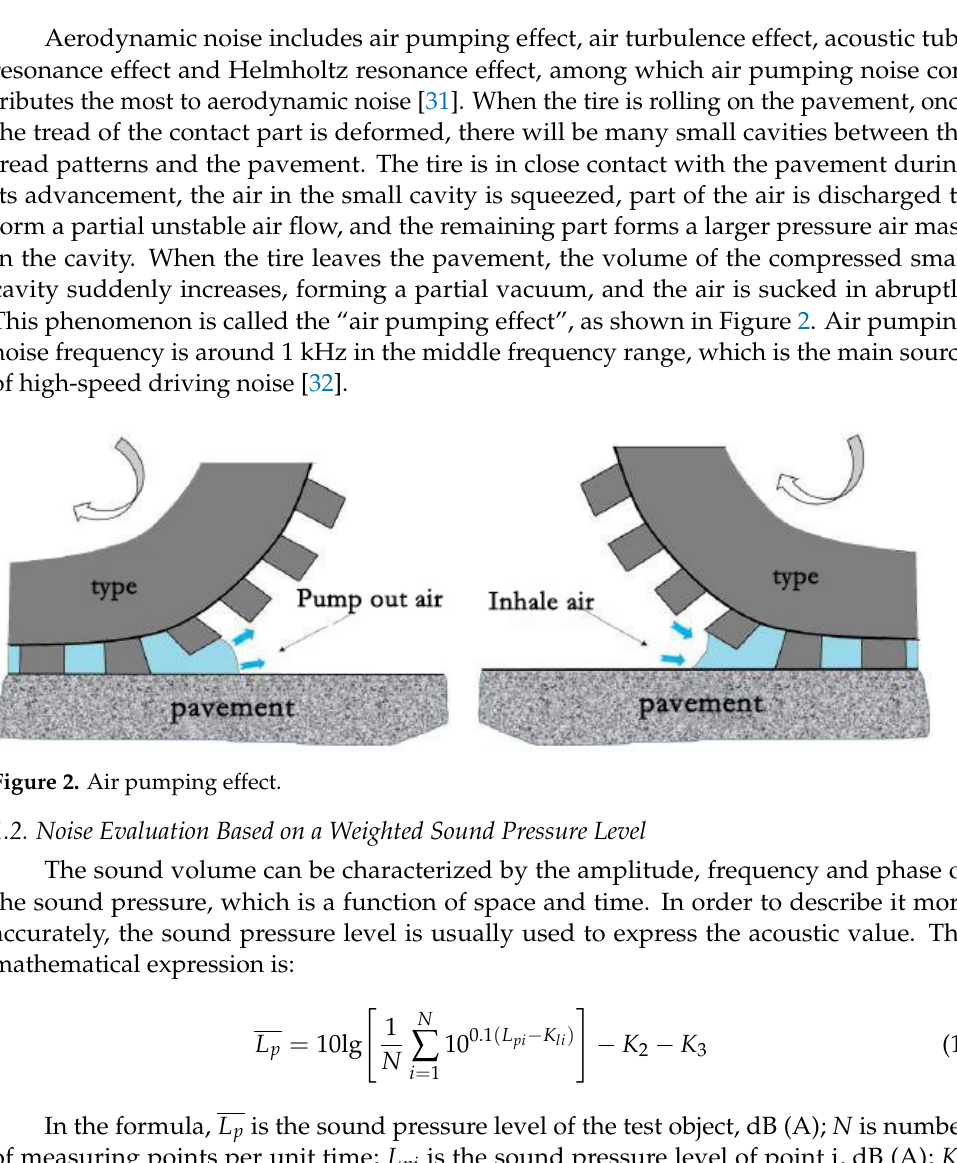
Figure 1. Tire vibration and noise.